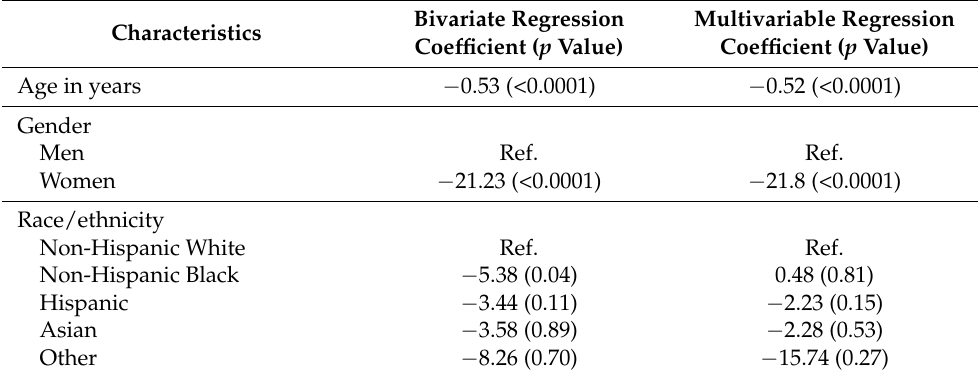
Table 2. Relationship of handgrip strength (HGS) with independent variables among WTC